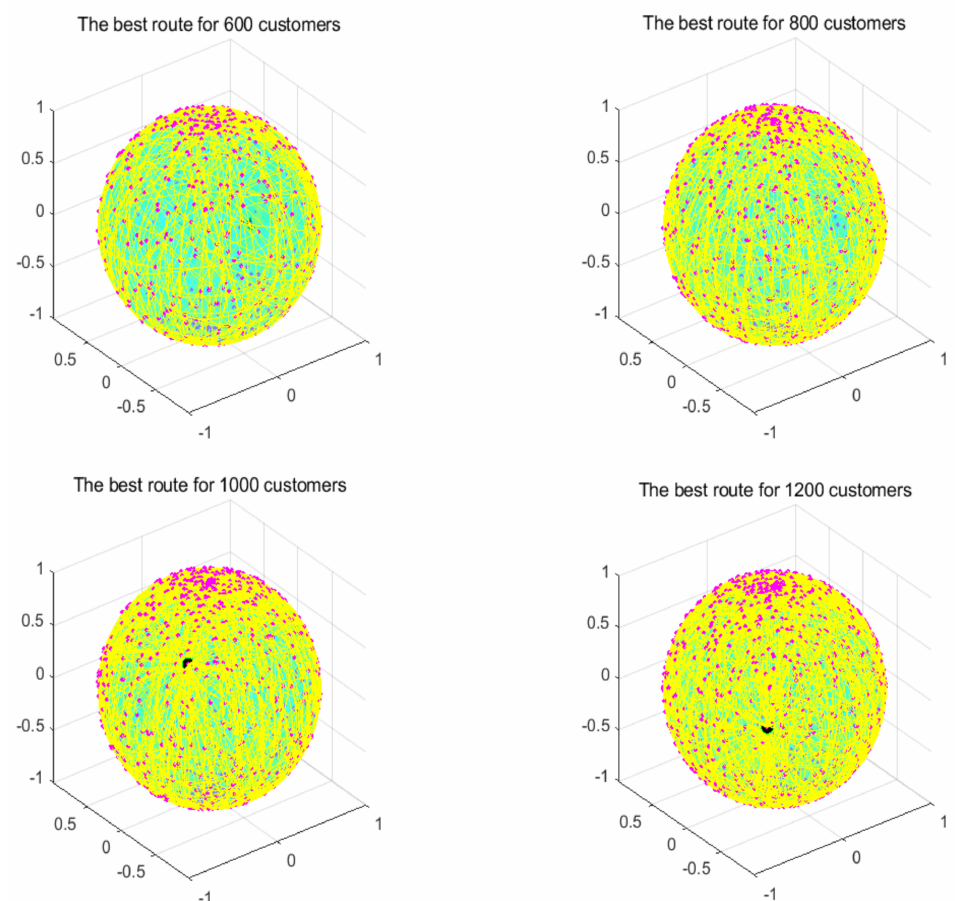
Figure 17. Optimal paths found by the proposed